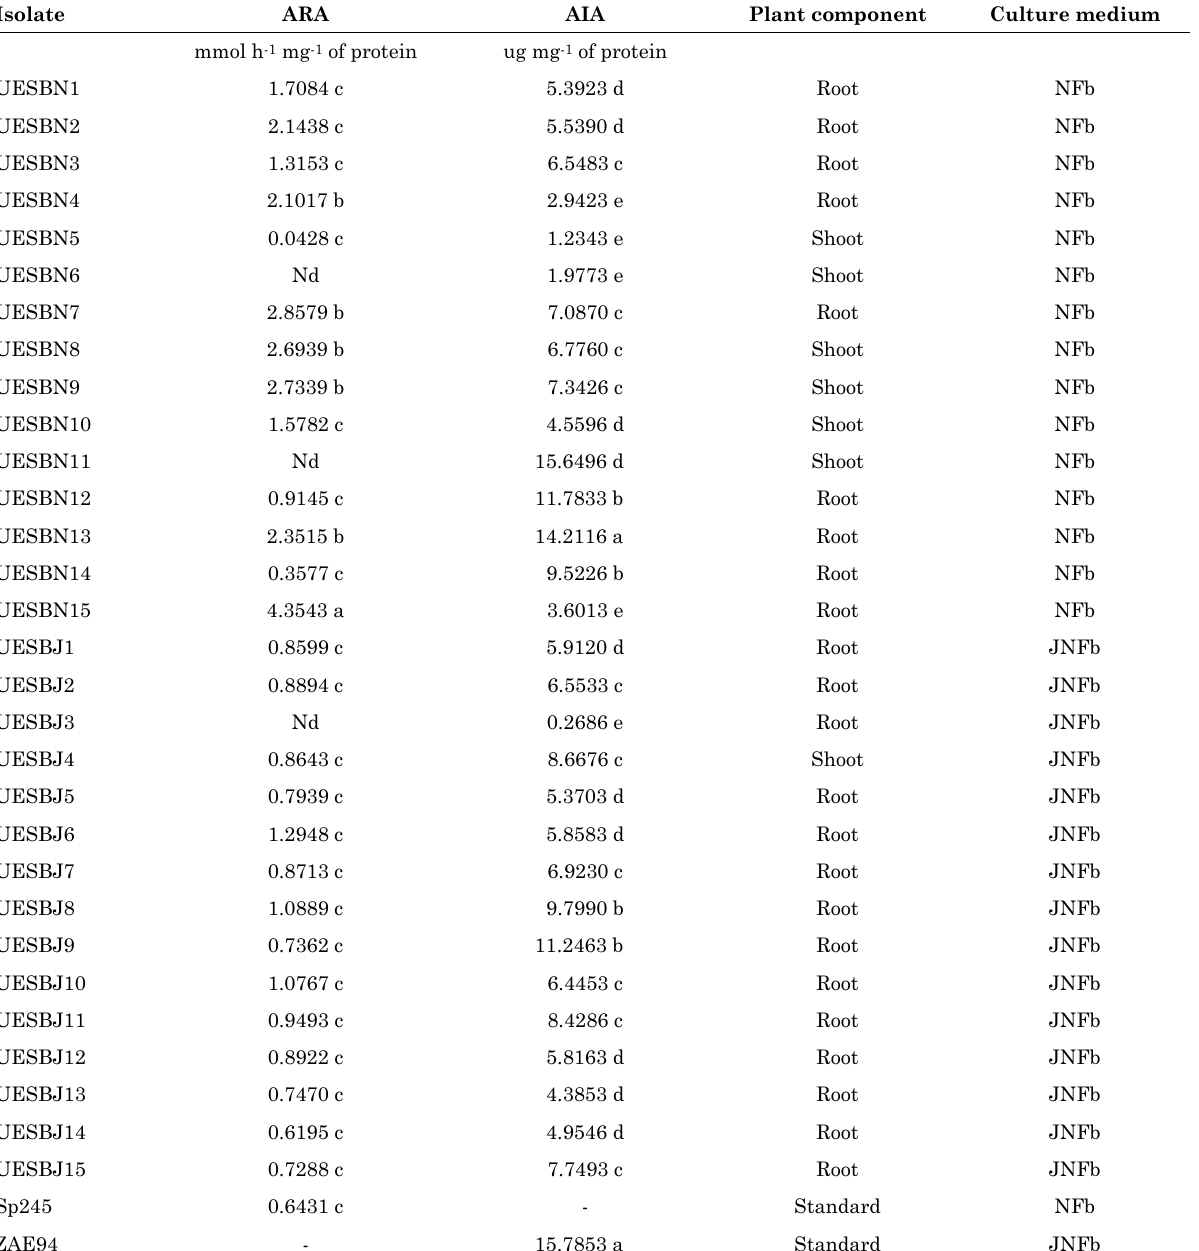
Table 2. Acetylene reduction activity (ARA), synthesis of indole acetic acid (IAA) by native strains isolated from maize plants AG 1051 and standard bacteria Isolate